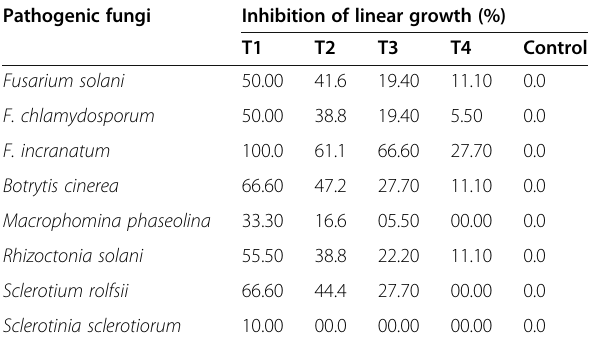
Table 4 In vitro antifungal activity of xylanase from A. oryzae on mycelial growth of some pathogenic fungi Pathogenic